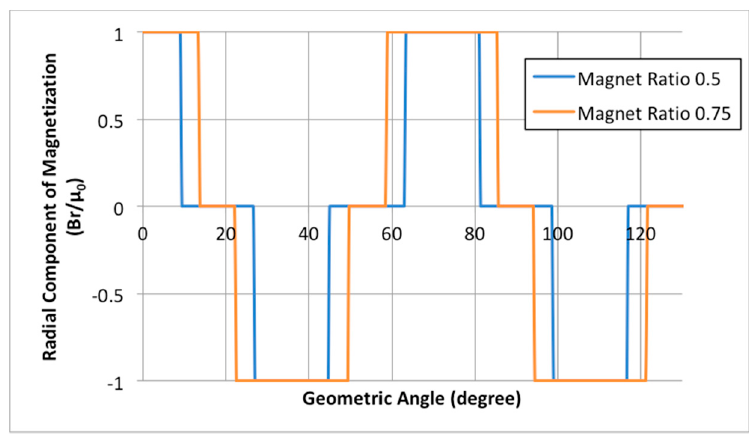
Figure 2. Radial Component of Magnetization for Two Magnet Ratios (0.5 and 0.75).